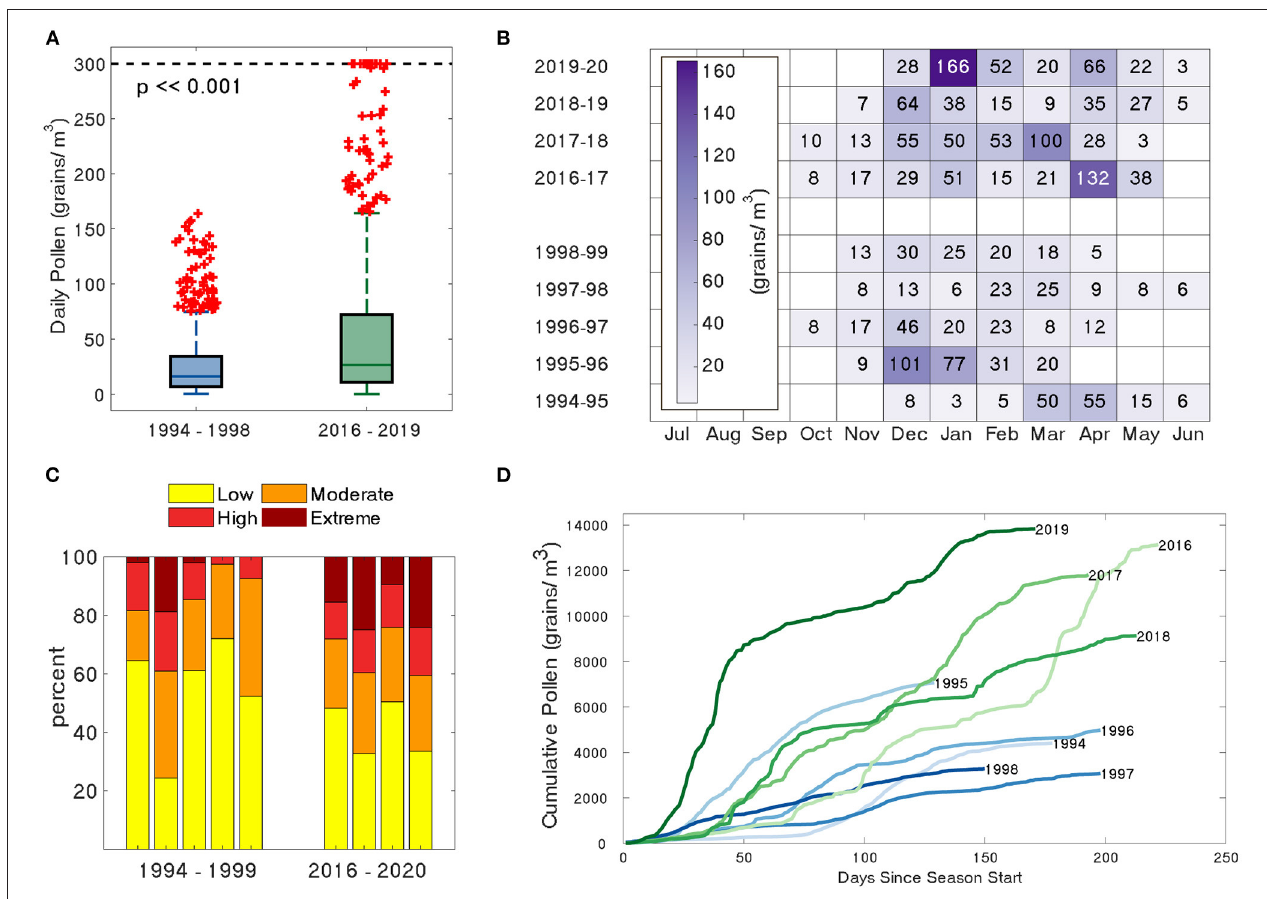
FIGURE 2 | Comparison of (A) distribution of daily grass pollen concentrations capped at 300 grains/m 3 with values greater than three median absolute deviations from the median marked in red. Large proportions of outliers reflect the skewed distribution of the data. (B) Distribution of median monthly grass pollen concentration, (C) grass pollen severity (proportion of grass pollen in exposure categories) and (D) cumulative daily grass pollen concentrations since start of a season, between 1990s (blue) and 2010s (green)